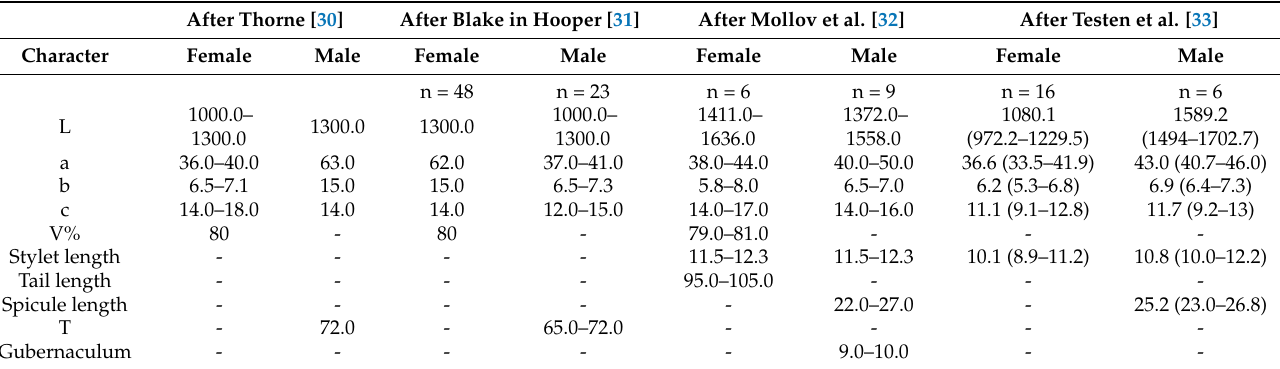
Table 2. Ditylenchus dipsaci morphometric of females and